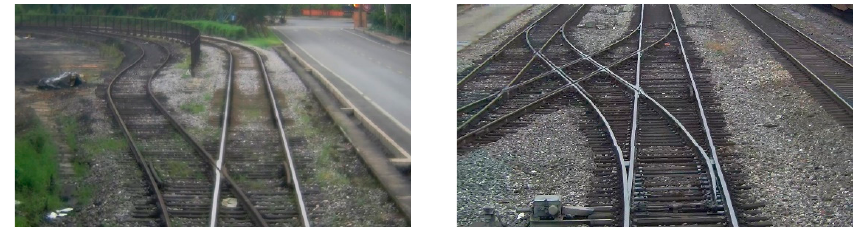
Figure 1. The complex environment of train tracks .